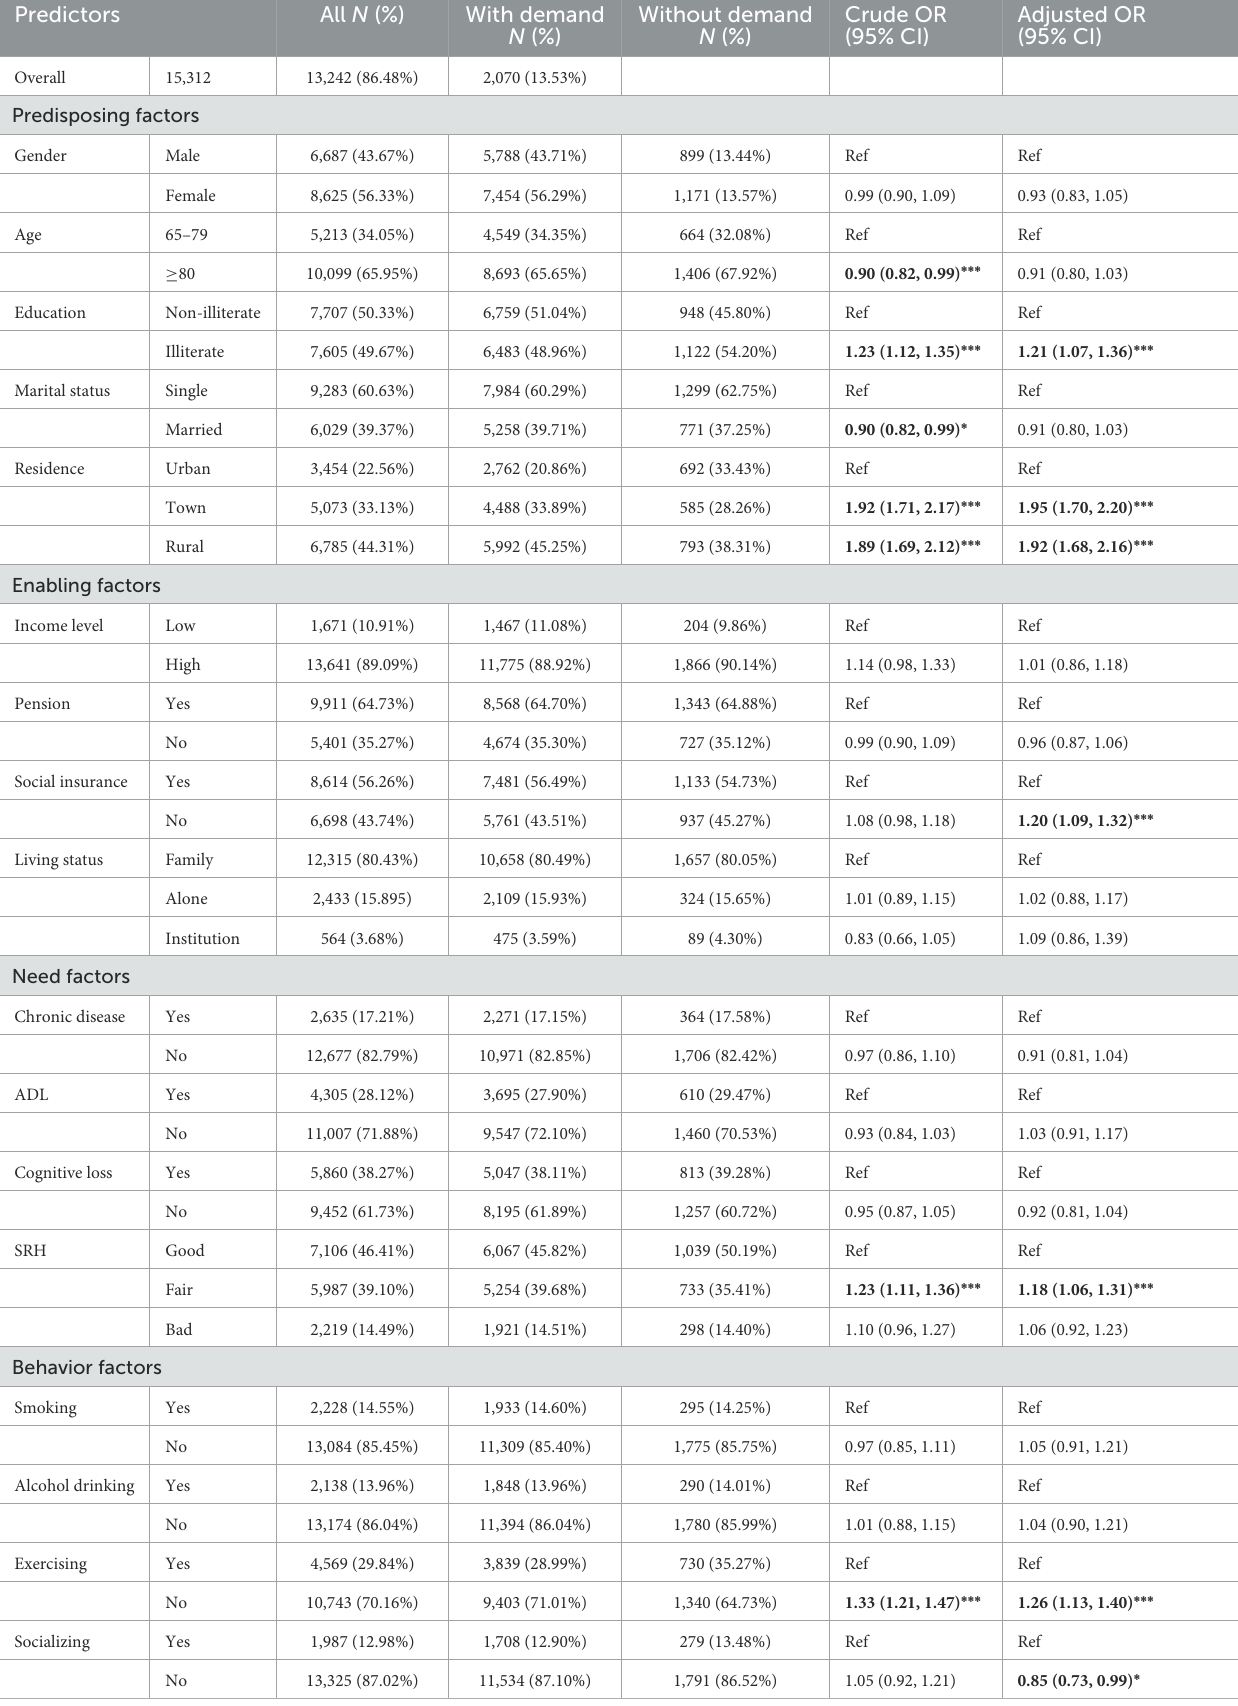
TABLE 1 Characteristics and odds ratio of older adults with demands of medical services provided by HCBS in CLHLS 2018.